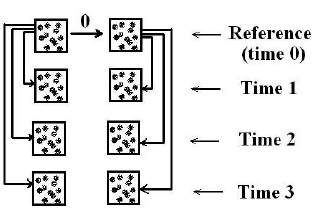
Figure 6. The principle of the image analysis used by VIC-3D [26,27,29].